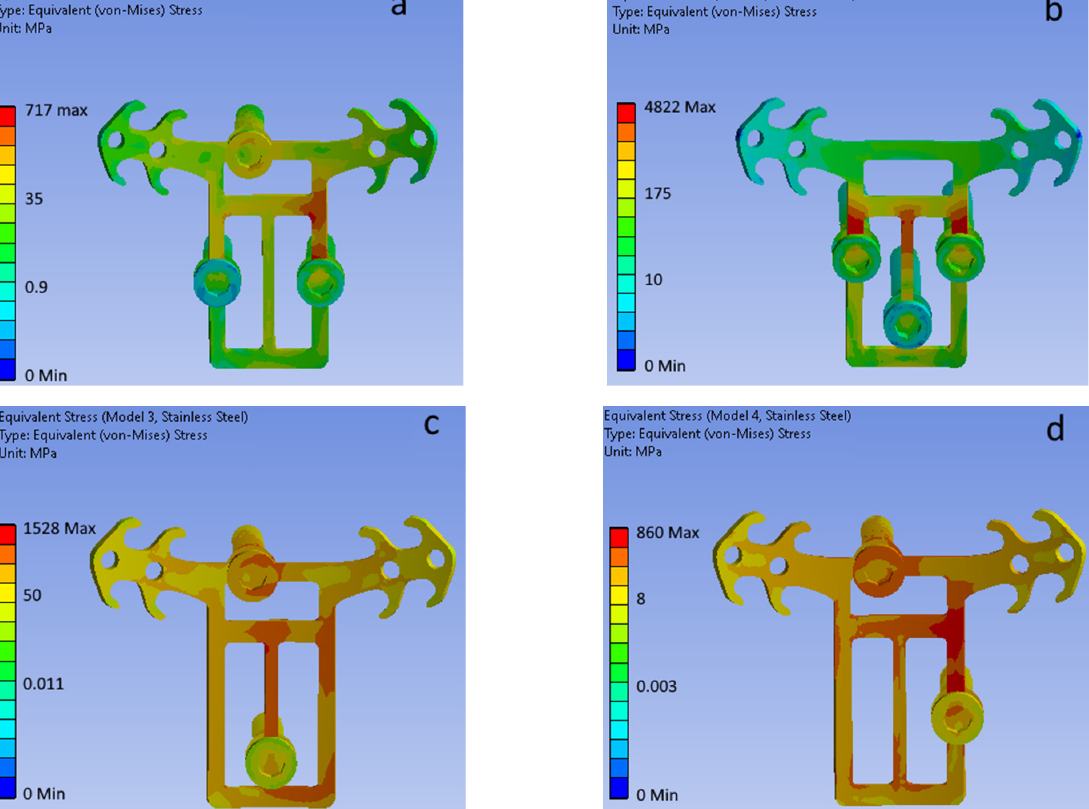
Figure 9. Equivalent stress field for ( a – d ) mini-implant configurations (POD material—stainless steel).